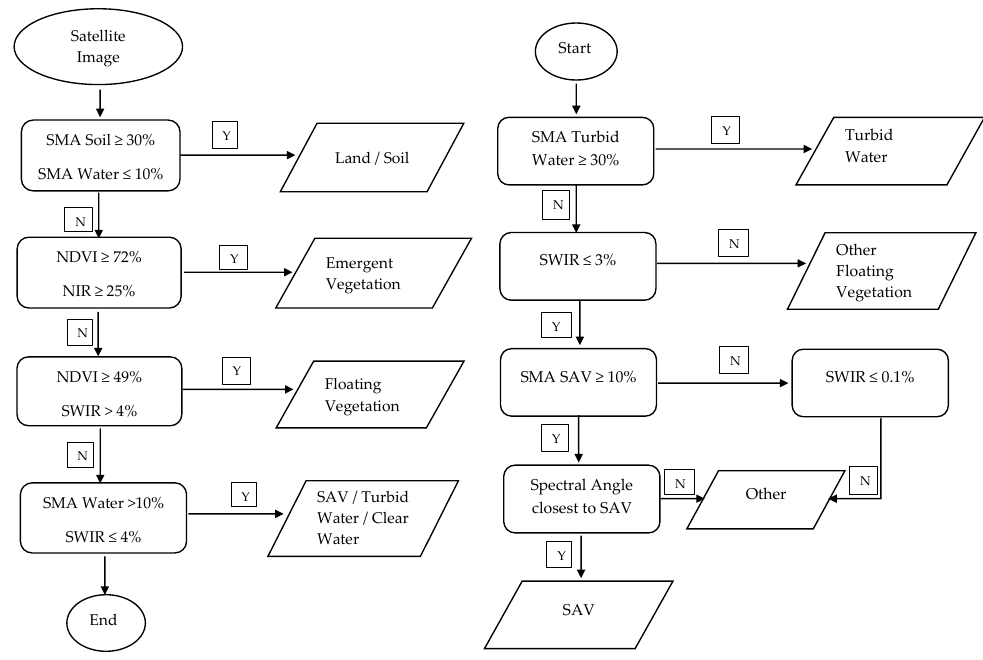
Figure 7. Decision tree classification developed for the extraction of land, emergent, and floating vegetation (on the left), and the extraction of SAV pixels from the turbid and clear water from the lake water (on the right). The two decision trees are in continuity from left to right (note: Y = Yes; N = No).